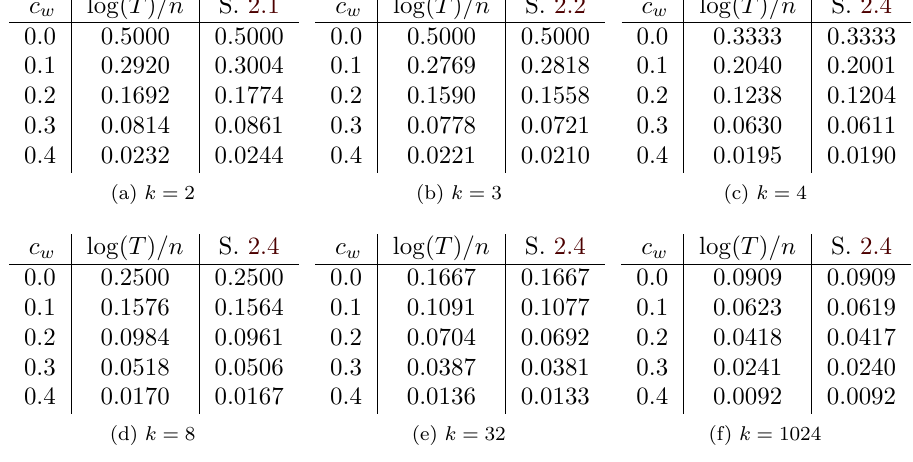
for various k , c w in comparison to Section n